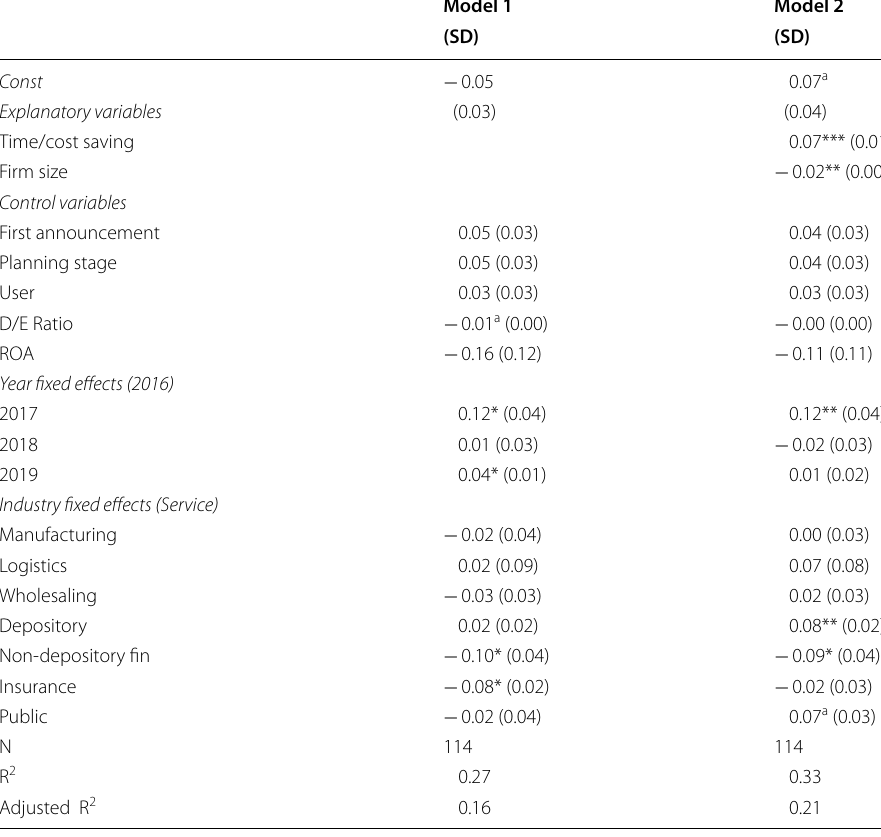
Table 5 Results of fixed-effects regression